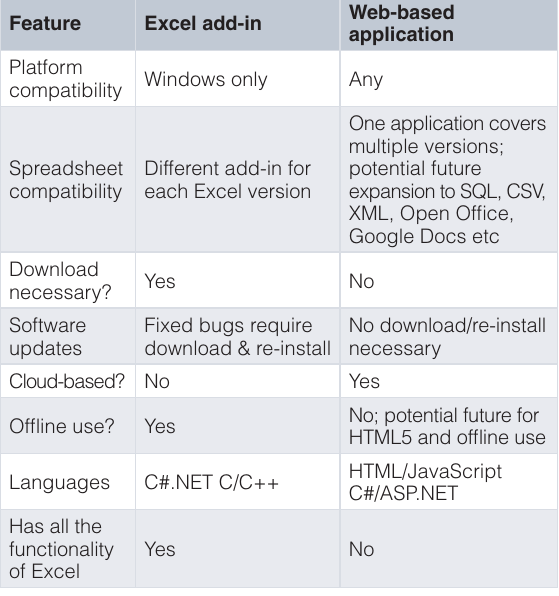
Table 2. Feature comparison for the two versions of the DataUp tool: add-in for Excel and Web-based application. Feature Excel